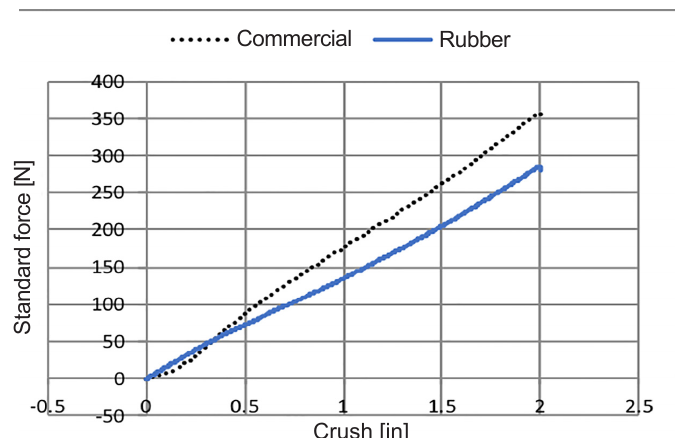
Figure 5. Tensile test results of simulated chest